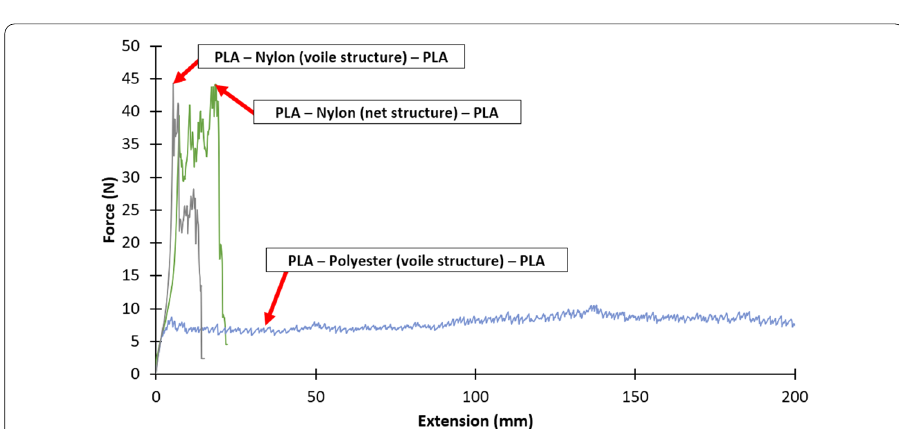
Fig. 10 Comparison of the force versus extension plots for the three bonded ME printed polymer–textile